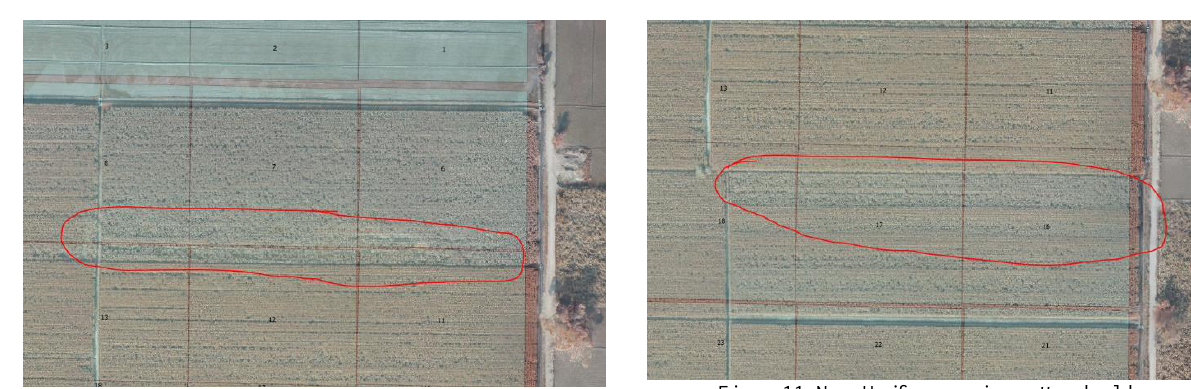
Figure 9. Low plants count problem due to water logging